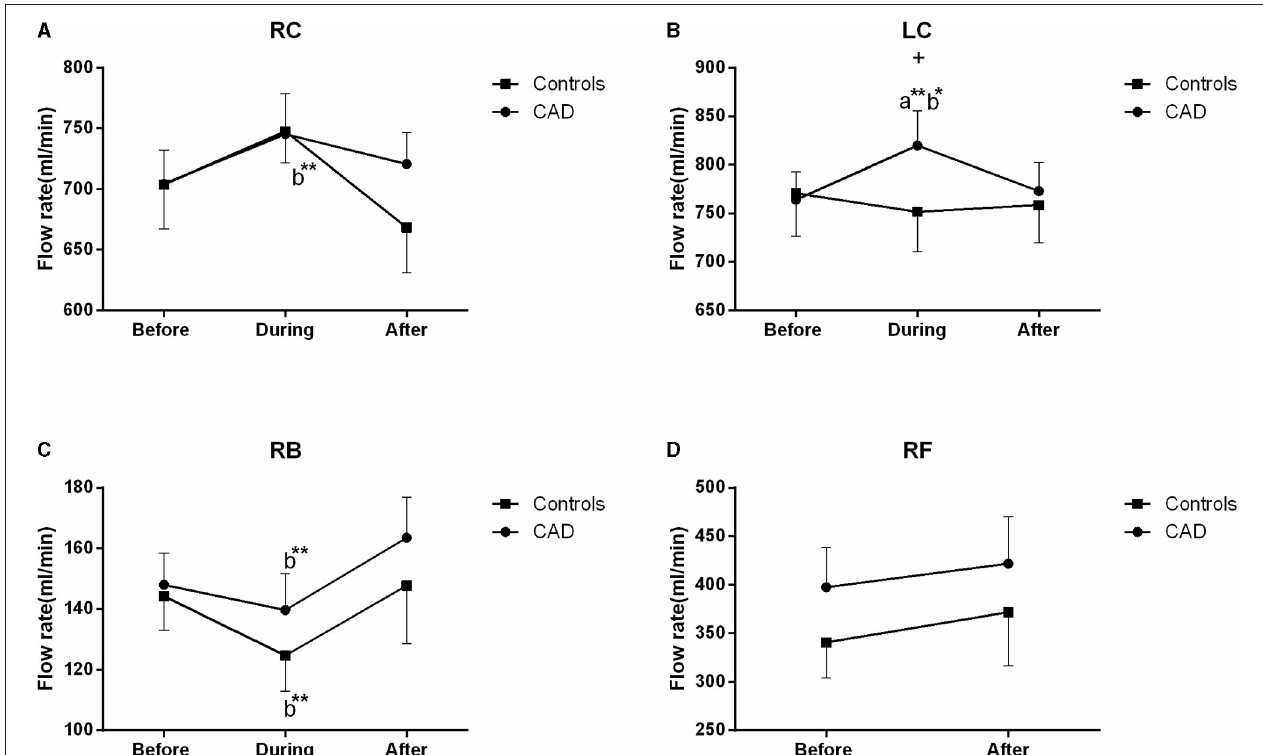
FIGURE 7 | Effect of EECP on the flow rate (FR) of RC and LC (A,B) , RB (C) , and RF (D) in the patients with CAD and controls before, during, and after a 45 min-EECP. a indicates significant differences in measurements obtained during EECP vs. pre-EECP; b indicates differences between post-EECP vs. during-EECP. * and ** denote p < 0.5 and < 0.01 respectively. + denotes p -values of the difference between groups <